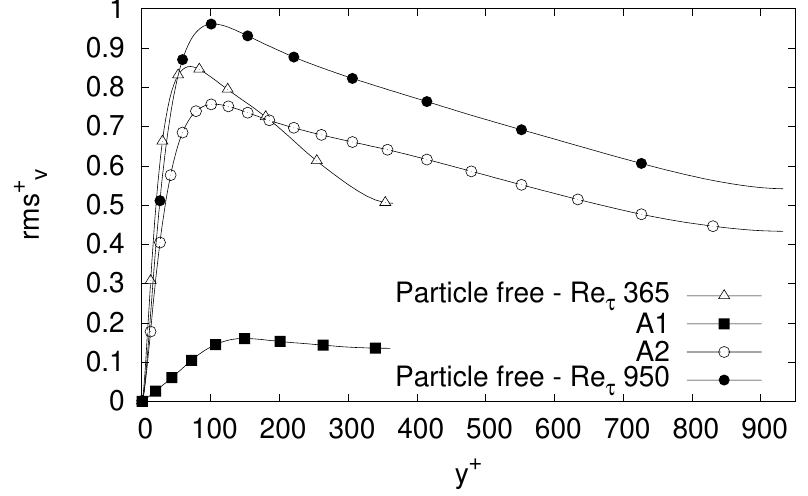
Figure 13. rms + v - Profiles for A1, A2 and particles free cases. ( A 1 : u τ = 0.073; A2: u τ = 0.188).